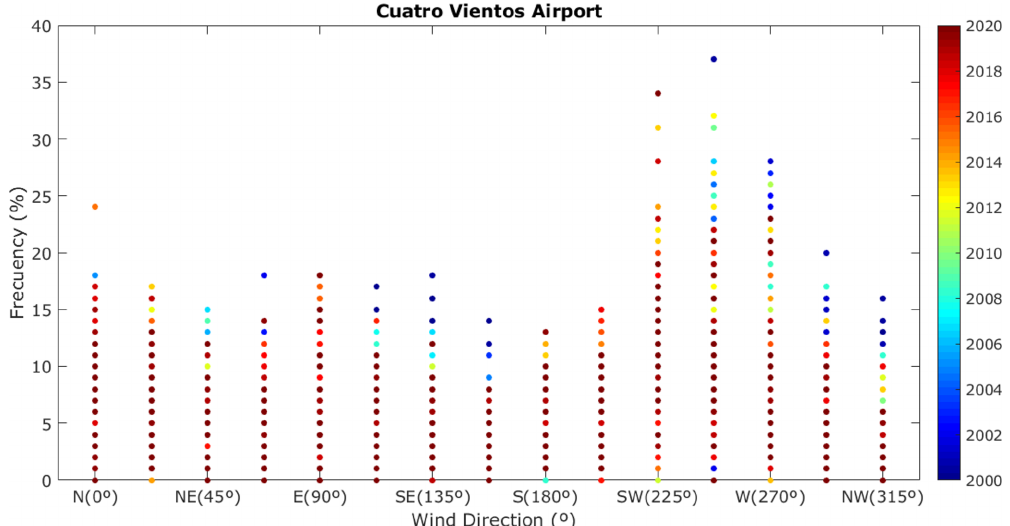
Figure A3. Percentage of occurrence for wind direction measured at the Cuatro Vientos Airport between 2000 and 2020. The predominant wind direction is southwest and up to 35% of time.